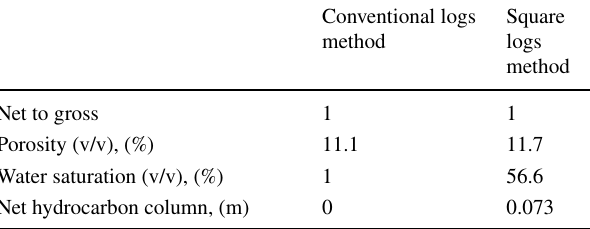
Table 3 Petrophysical parameter calculated from conventional (the standard resolution) and square (high resolution) logs methods with- out